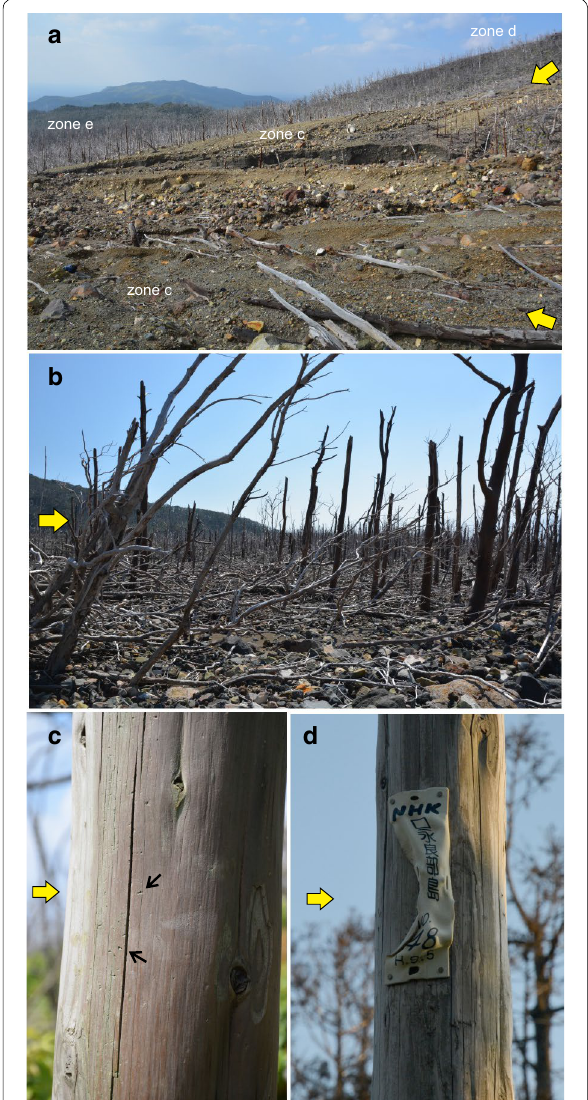
Fig. 5 The variation in the mechanical damages by PDC. Yellow arrow indicates the flow direction of the PDC in each location. a The western flank of Shindake, ~ 1 km from the crater. The trees had fallen down and were buried by the block-and-ash flow deposit (Zone c). All trees in the right of the far field had fallen down toward the flank (Zone d). Most of trees in the left of the far field remained standing (Zone e). b The trees broken and fallen down by the blast of the PDC in the western flank of Shindake, ~ 1 km from the crater. c Melted and deformed plastic plates on the electric pillar in Zone d. d Small impact pits on the wood pillar in Zone d ~ 2 km from the